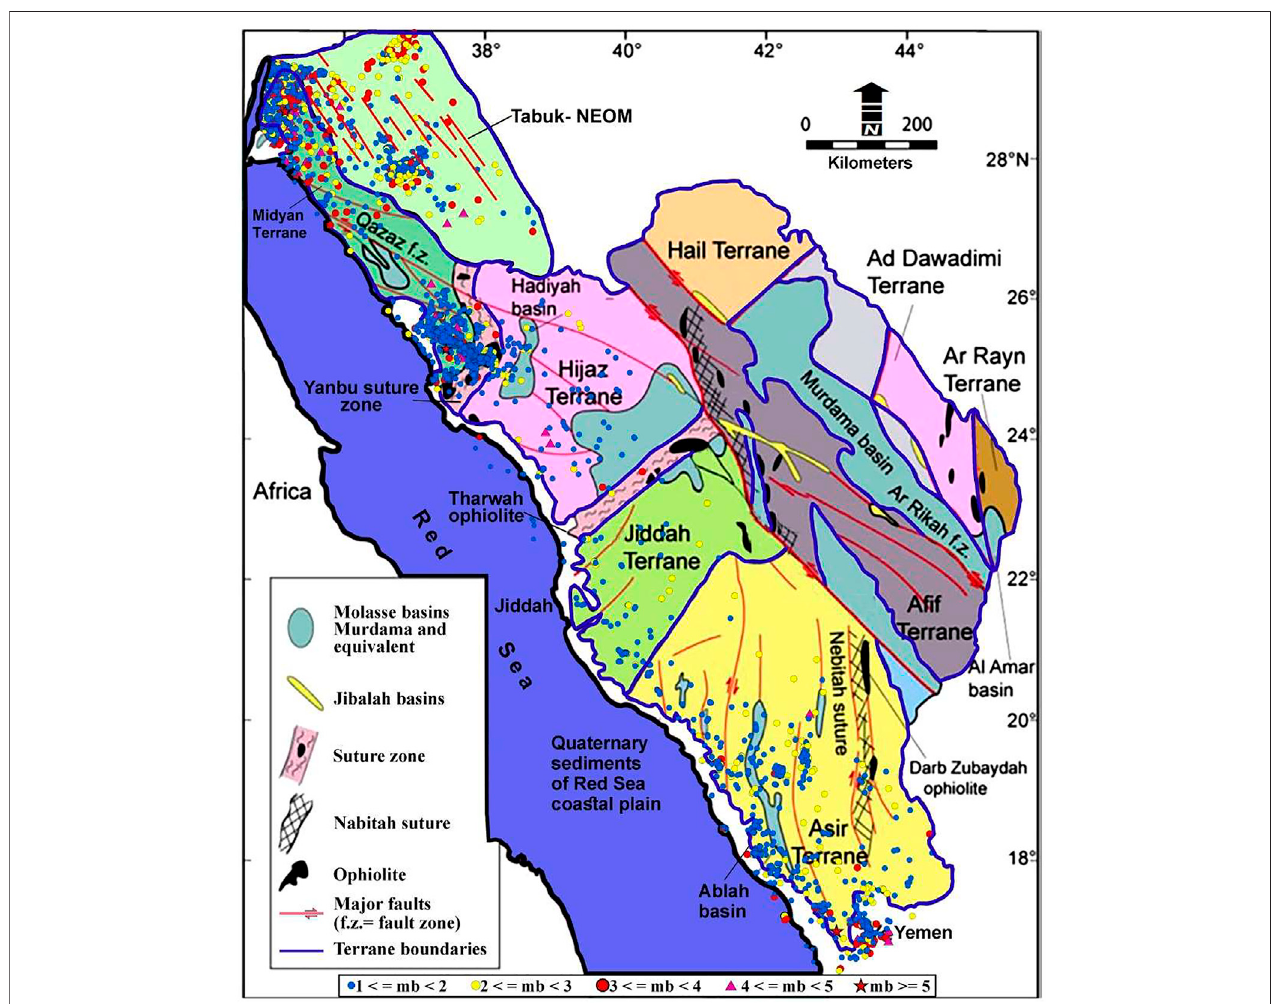
FIGURE 2 | Geologic map of the Arabian Shield showing the major geologic terranes and their boundaries, Najd fault system, and sedimentary basins (modi fi ed after Al-Amri et al., 2004) and the seismic activity from 1980 to 2019 using the International Seismological Centre catalog (ISC, 2021).